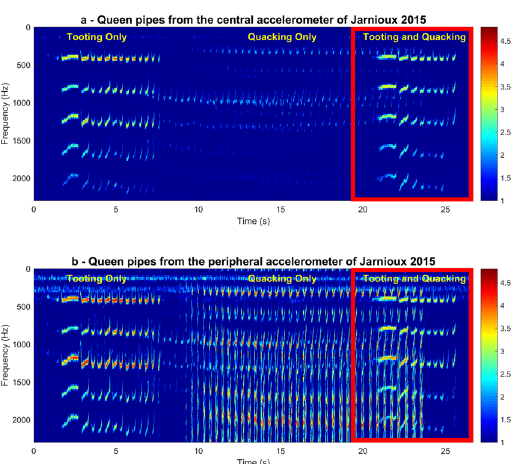
Figure 8. Spectrogram of raw spectra containing the toots and quacks found in the section highlighted in Fig. 7. Data are shown for the accelerometers situated at the centre (Top, a ) and at the periphery (Bottom, b ) of the frame. Pixel intensity represents logarithmic spectral amplitude from low (blue) to high (red) in arbitrary units. Highlighted in the red rectangle is the small sample of data further analysed in Fig. 9. This figure was created using the MATLAB (R2018b) software